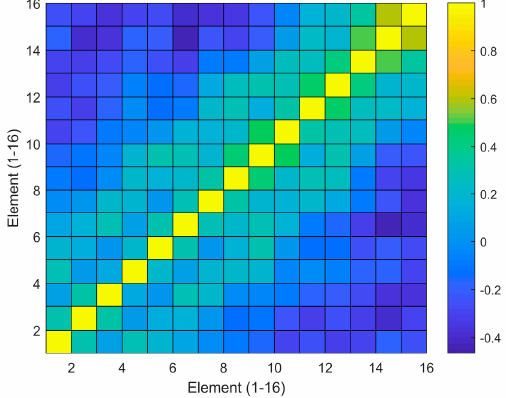
Figure 14. Noise correlation coefficients.